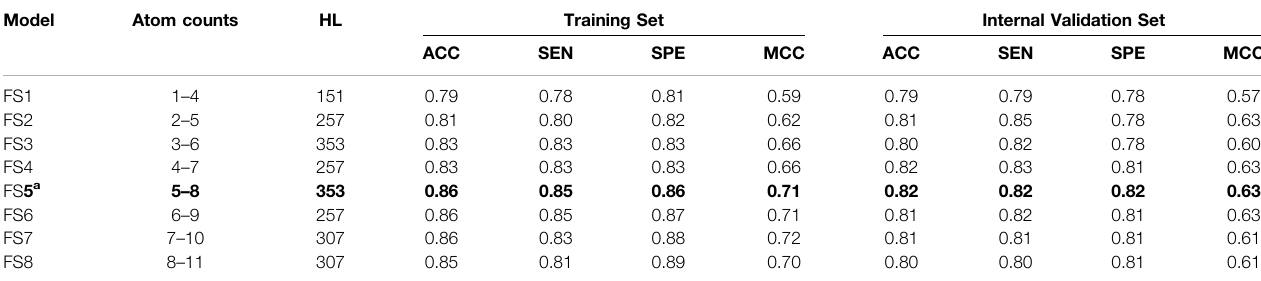
TABLE 4 | Performance of the PLS-DA models based on different fragment sizes. Model